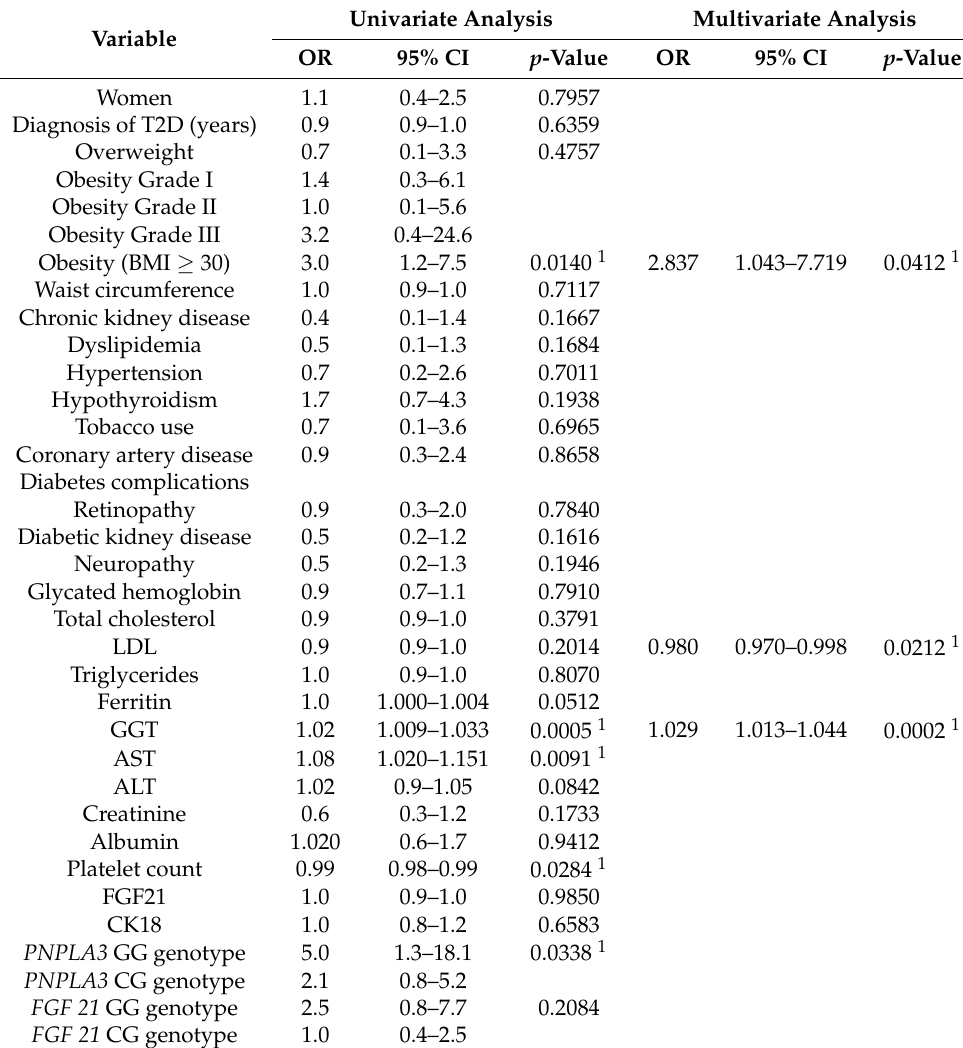
Table 3. Factors associated with significant liver fibrosis in NAFLD patients with T2D ( n = 127). Univariate Analysis Multivariate Variable